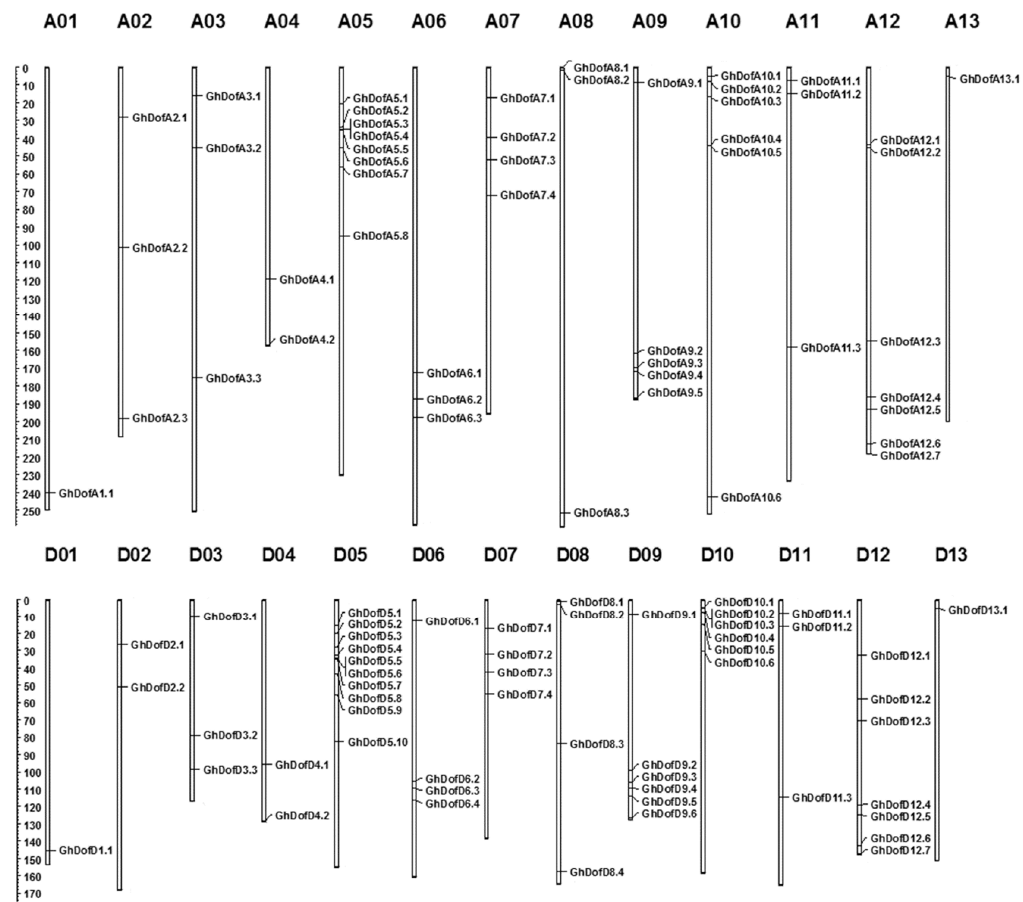
Figure 1. Chromosomal locations of GhDof genes on 26 chromosomes. A1–A13 and D1–D13 indicate the A-subgenome and D-subgenome, respectively.